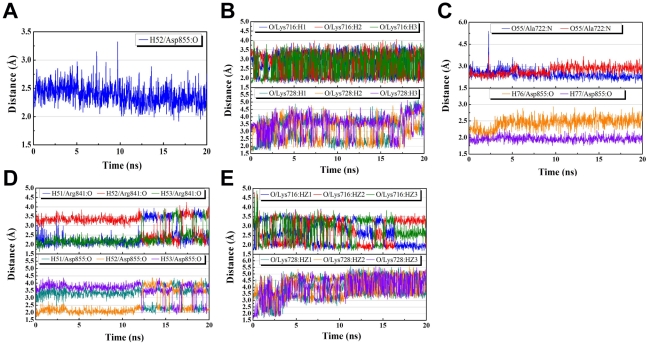
Hydrogen bond distance profile during MD simulation.(A) Iressa, (B) 2-O-Caffeoyl tartaric acid, (C) Emetine, (D) Rosmaricine, (E) 2-O-Feruloyl tartaric acid.